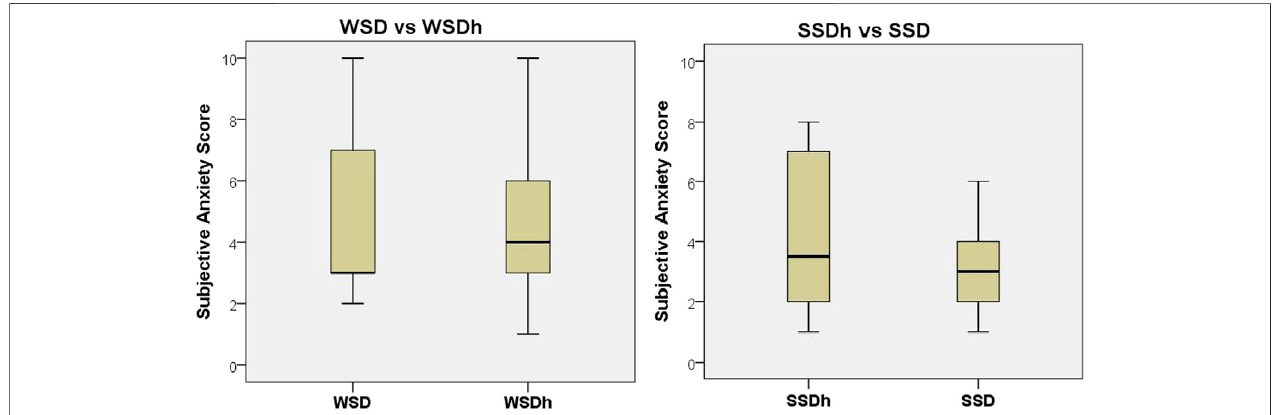
FIGURE 8 | Box and whisker plots showing comparisons of self-reported anxiety scores for two scenarios with and without haptics.